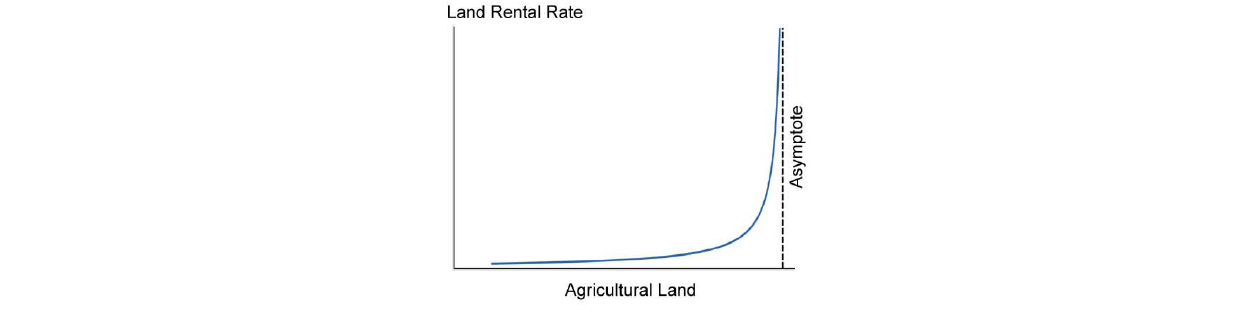
Fig. 2 . Land supply curve determining land conversion and land rental rate (source MNP